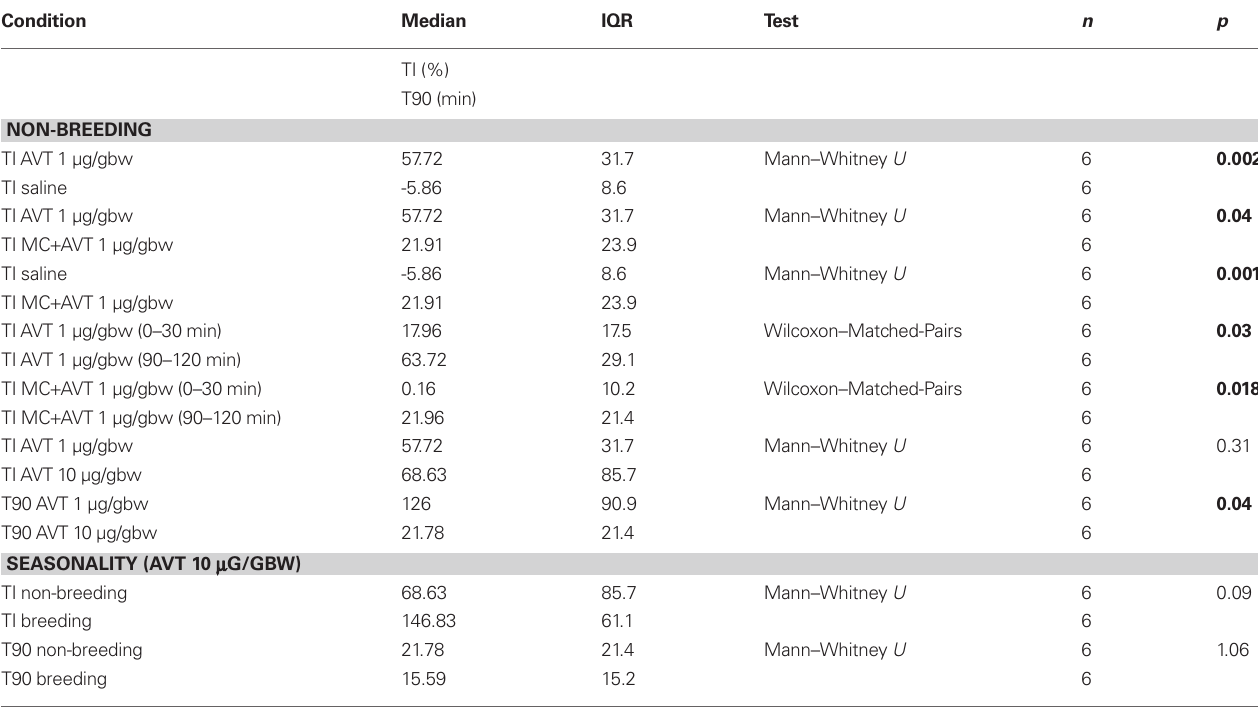
Table 1 | Quantification of the effects of AVT upon EOD rate in Brachyhypopomus gauderio. Condition Median